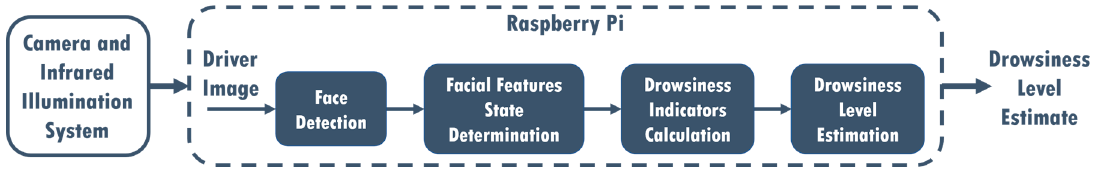
Figure 1. Portable Fuzzy Drowsiness Estimation System (PFDESys) .